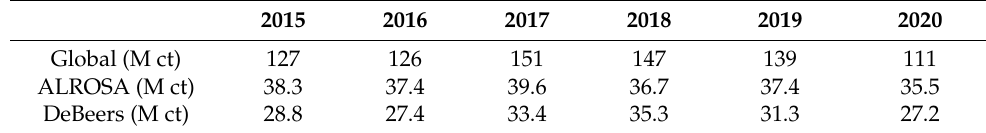
Table 3. Annual diamond production for 2015–2020 (Bain & Company